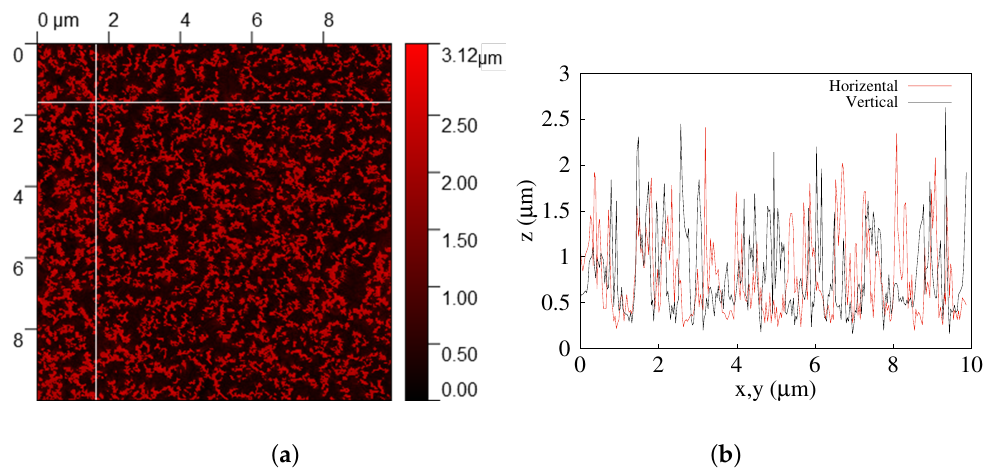
Figure 2. ( a ) Gwyddion analysis of top-view SEM image in (100µm 2 ). ( b ) Two Gwyddion line-scans of the figure to the left (red color—horizontal axis, black color—vertical axis).